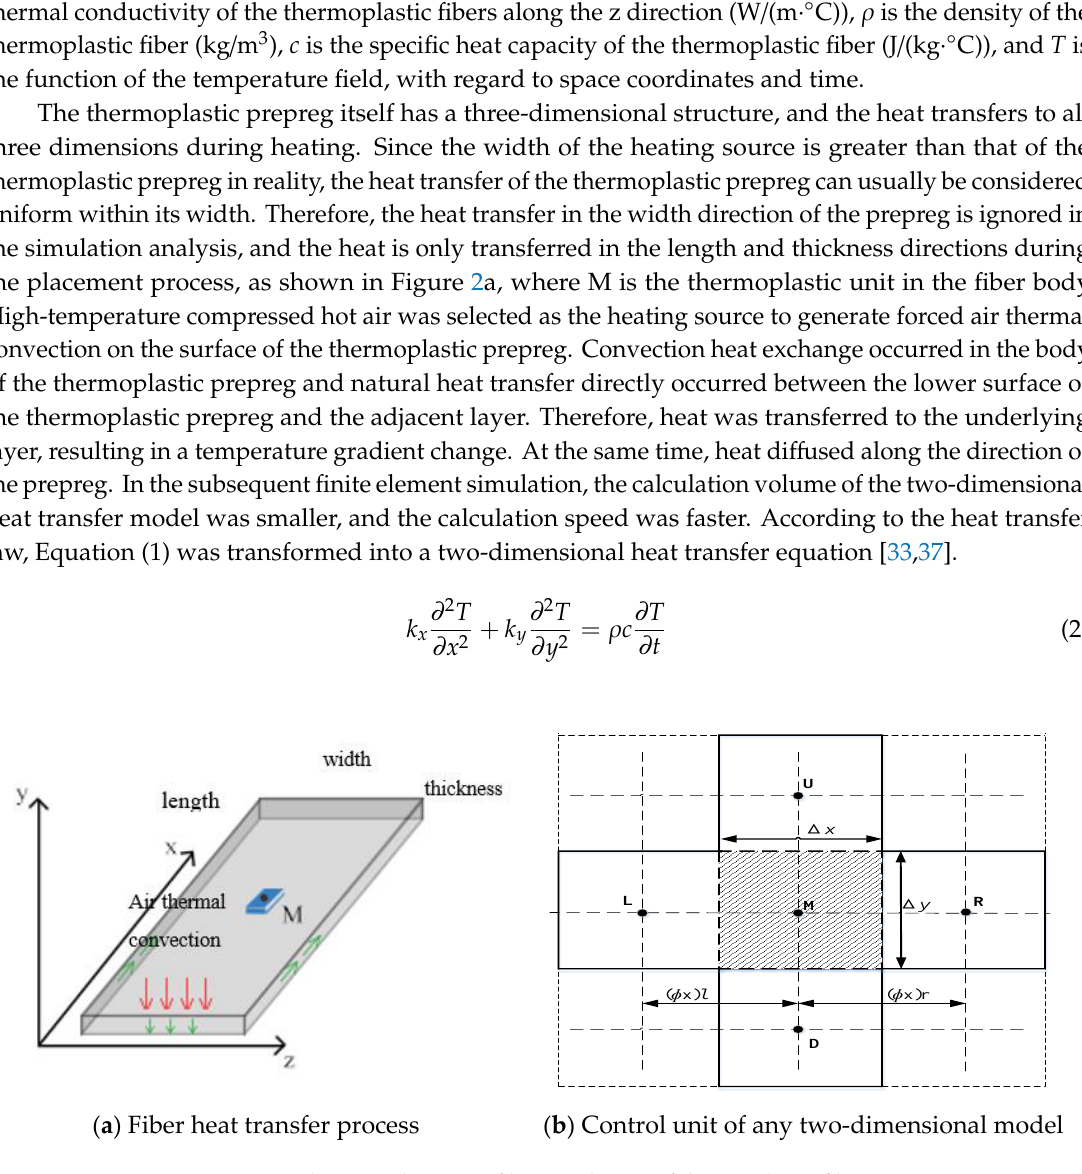
Figure 2. Schematic diagram of heat exchange of thermoplastic fibers.